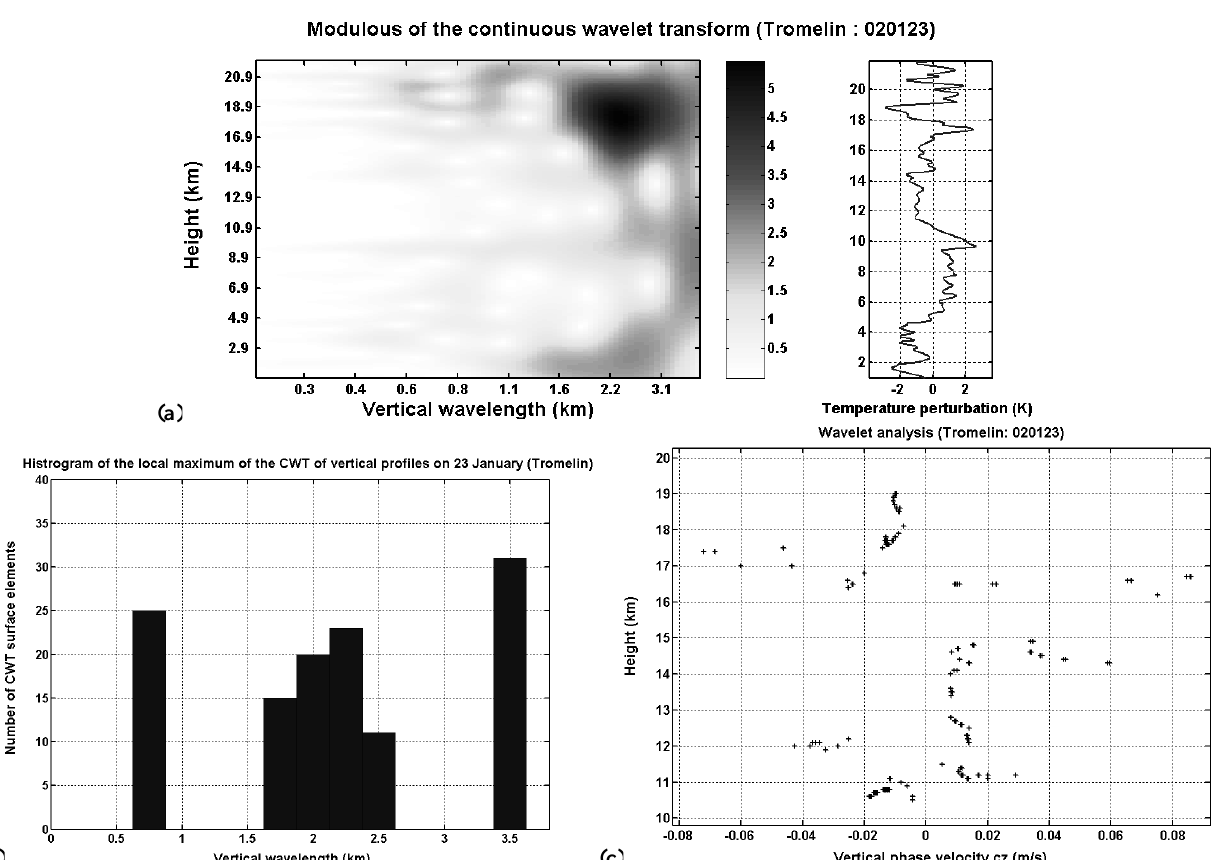
Fig. 6. Continuous wavelet transform applied on vertical profiles of temperature and horizontal winds observed above Tromelin on 23 January. (a) vertical wavelength-height diagram of CW modulous for temperature perturbations, (b) histogram of the CWT local maximum and (c) the vertical phase speed-height diagram for the coherent gravity-wave with 2.4km vertical wavelength detected by the wavelet